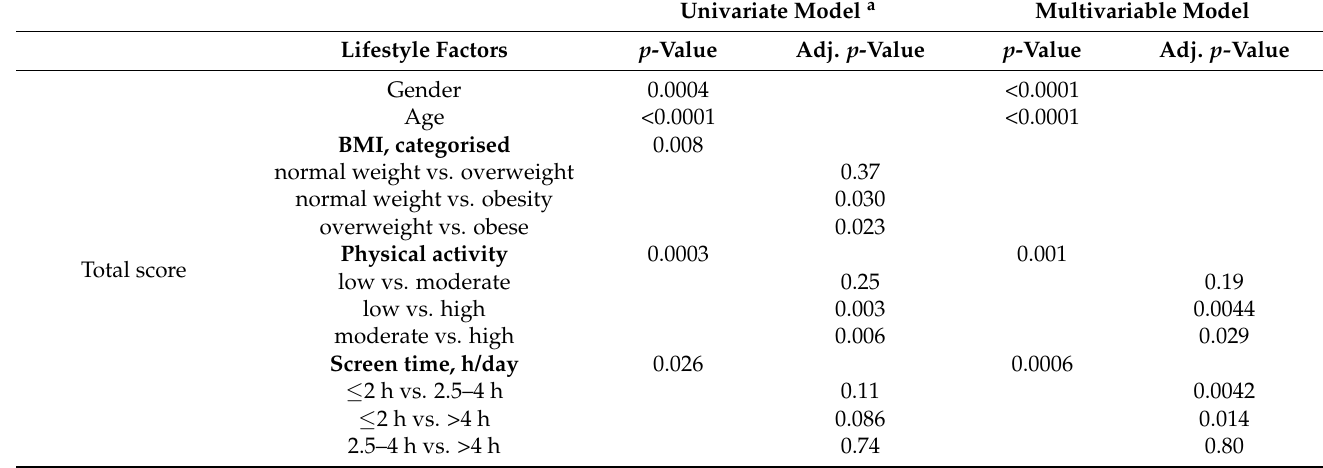
Table 5. Associations between the child’s reported PedsQL scores and lifestyle factors. A linear model was first performed for each of the lifestyle factors separately and then a multivariable model was built for all significant factors. Subsequently, a multivariable model was simplified by removing non-significant terms one-by-one. The final model is presented in the table below. When a factor was statistically significant, then a pairwise testing between all categories was performed and p -Values were corrected with Tukey’s method. Transformation was necessary for both the total score and subscales in order to achieve the assumption of normality. First, subtraction from 101 was calculated (where 100 was the maximum score for each of the scores) and then a square root transformation was